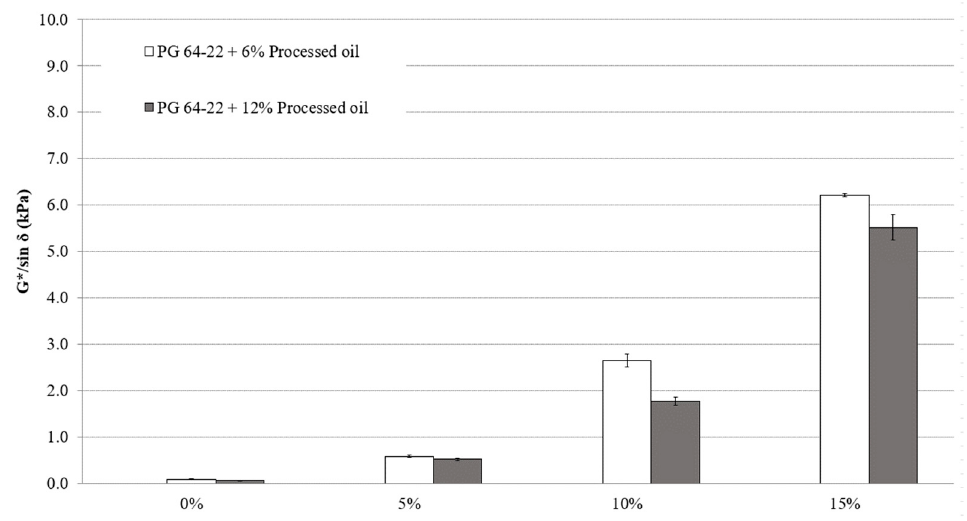
Figure 4. G*/sin δ of PG 64-22 binders with processed oil as a function of SBS content at 82 °C. Table 8. Statistical analysis results of G*/sin δ for PG 64-22 with processed oil as a function of SBS content ( α = 0.05).